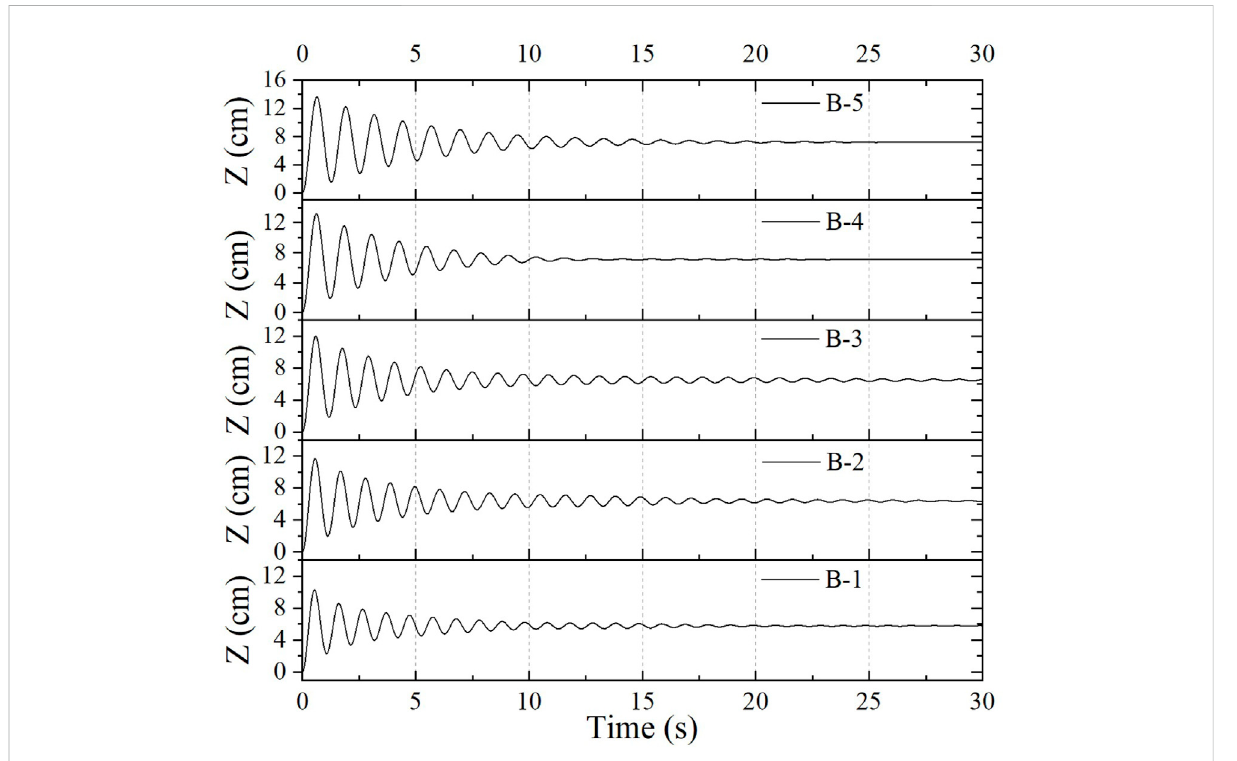
FIGURE 13 Time series of the simulated free decay test of model B with different drafts in heave motion.